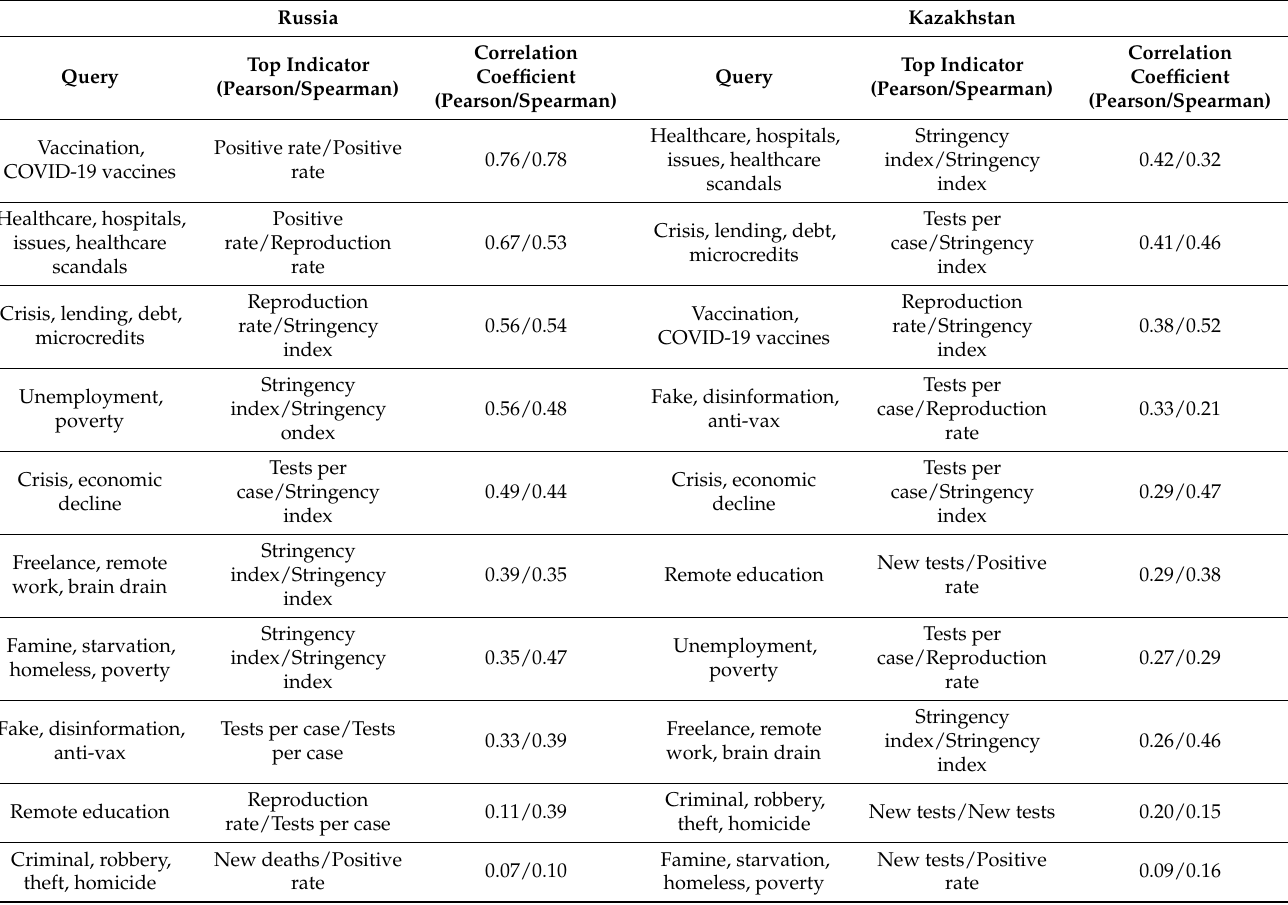
Table 8. Correlation between average relative weights of queries and indicators with the highest